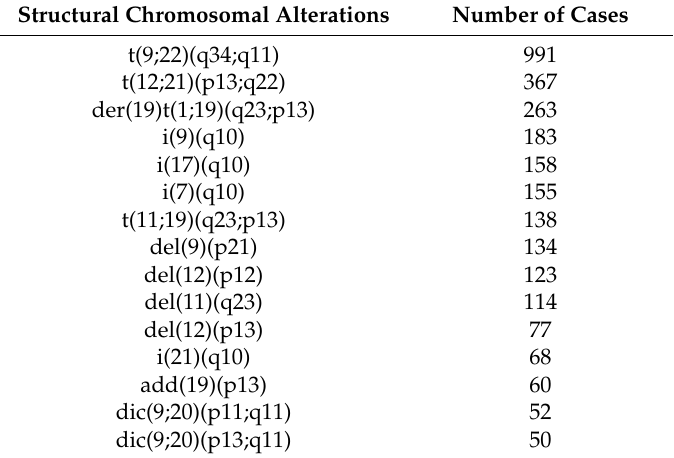
Table 1. Chromosomal alterations observed at high frequencies in High Hyperdiploid Acute Lymphoblastic Leukemia (HeH